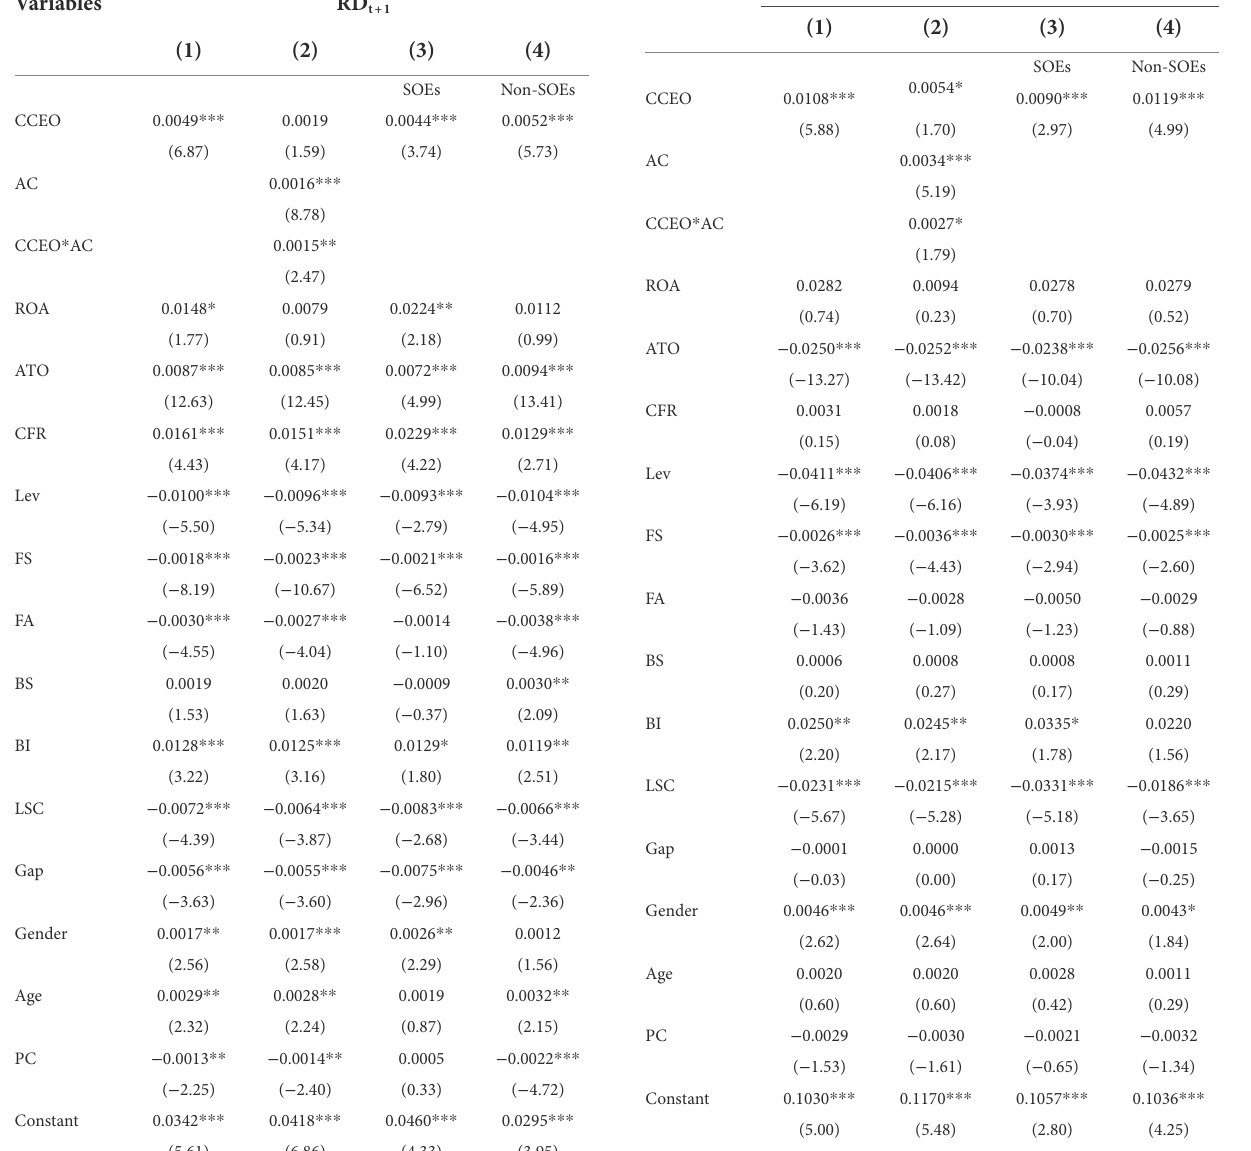
TABLE 7 Robustness test: Replacing the measure of innovation investment. Variables